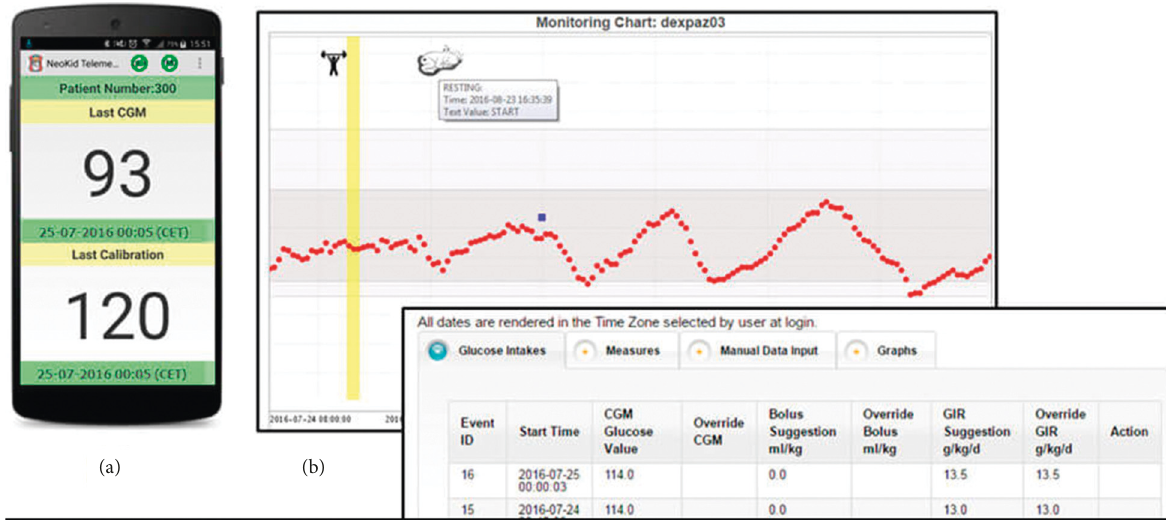
Figure 4: Continuous glucose monitoring chart